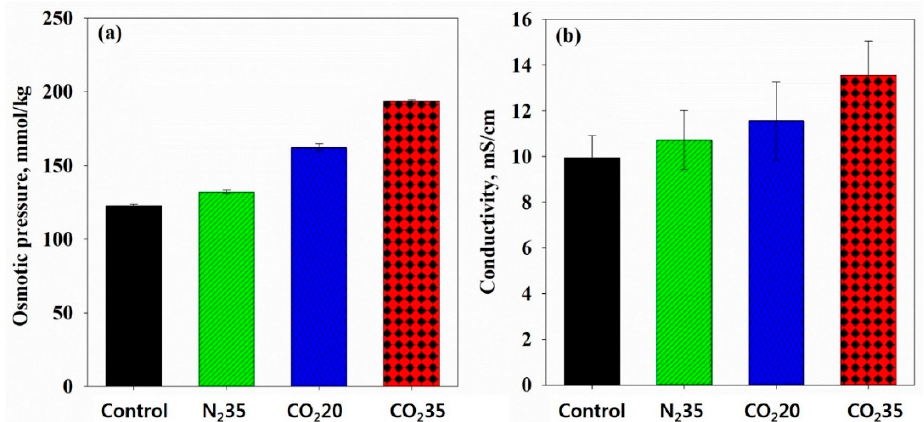
Figure 6. ( a ) Osmotic pressure and ( b ) conductivity of the filtrate separated from the sludge samples.